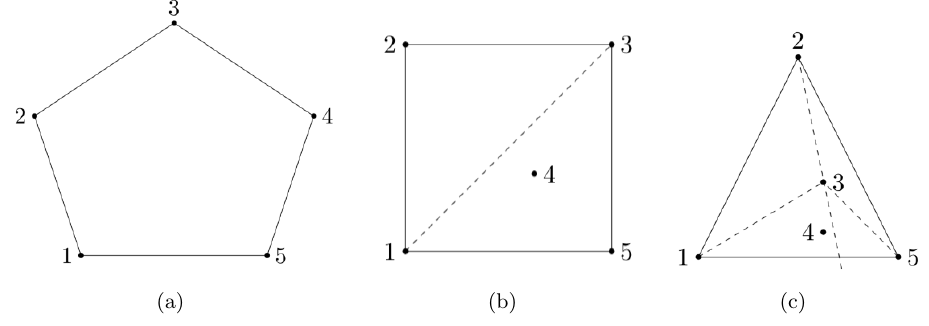
Figure 10 . (a) Pentagonal con(cid:12)guration 12345 with the region bounded by the lines (12)(45)(15) for B (cid:11) ; (b) Quadrilateral con(cid:12)guration with the region bounded by lines (12)(15)(34) for B (cid:11) ; (c) Triangular con(cid:12)guration giving the same region for B (cid:11) as